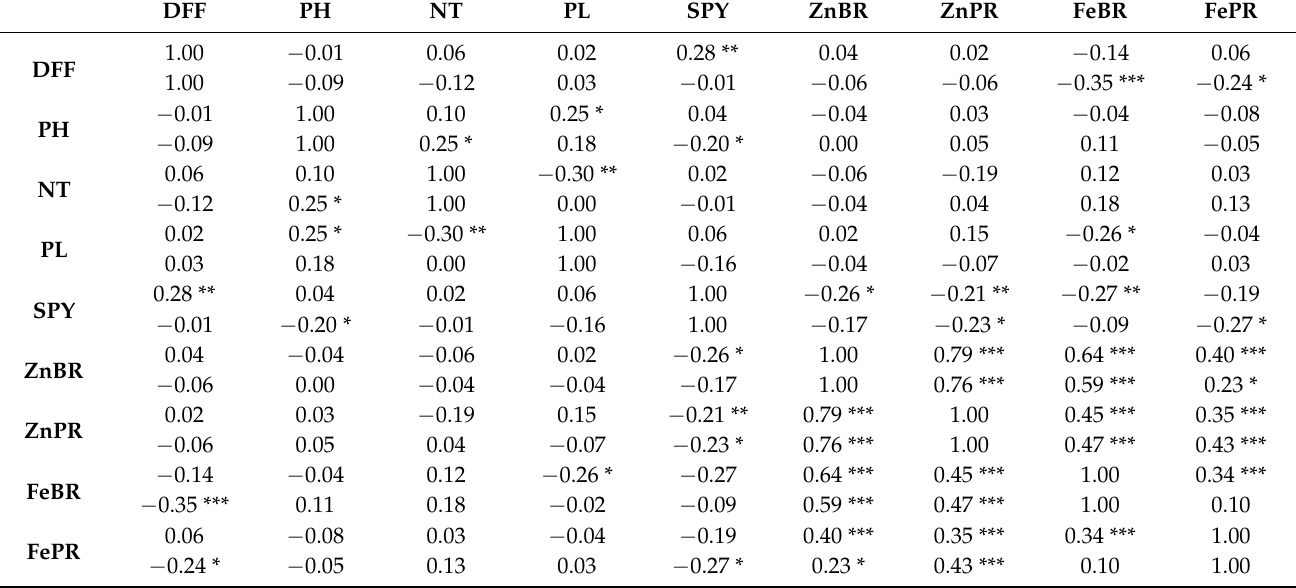
Table 2. Pearson correlation analysis for agronomic, yield-, and mineral-related traits evaluated during two wet seasons (WS) and two dry seasons (DS) (average).